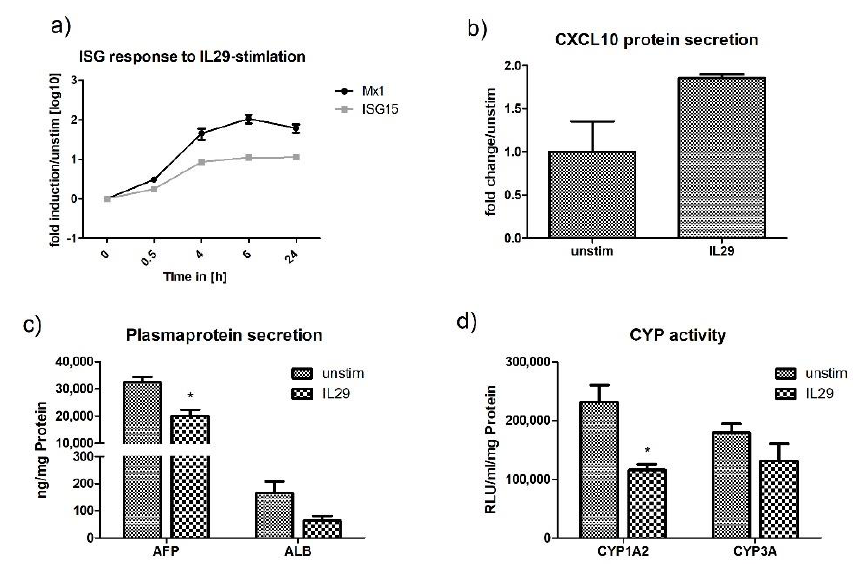
Figure 7. IL29 induces anti-viral activity in P106-HLCs, which is accompanied by an immunometabolic switch. ( a ) P106-HLCs mount strong innate immune responses upon stimulation with the type III IFN IL29. Stimulation with IL29 induced ISG-expression (ISG15, Mx1) in a time-dependent manner, as determined by qPCR ( N = 3). ( b ) Expression of CXCL10 protein upon IL29 stimulation. CXCL10 protein levels in the supernatants were measured by ELISA 24 h after stimulation and confirmed the expression of CXCL10 protein ( N = 3). ( c ) E ff ect of innate immune activation on hepatocytes metabolic activity. Cells were stimulated with IL29 for 16 h before CYP-activity and plasma protein production was measured and compared with unstimulated cells. The generation of an inflammatory environment as determined by upregulation of cytokines and chemokines was accompanied by the downregulation of plasma protein production (AFP, ALB) and ( d ) cytochrome P450 (CYP1A2, CYP3A) in order to redirect intracellular energy into defense strategies ( N = 3). Results are shown as mean +/ − SEM. * p < 0.05. IL29 = interleukin 29, ISG = interferon stimulated genes, CXCL10 = C-X-C motif chemokine 10, AFP = alfa fetoprotein, ALB = albumin, CYP = cytochrome P450.